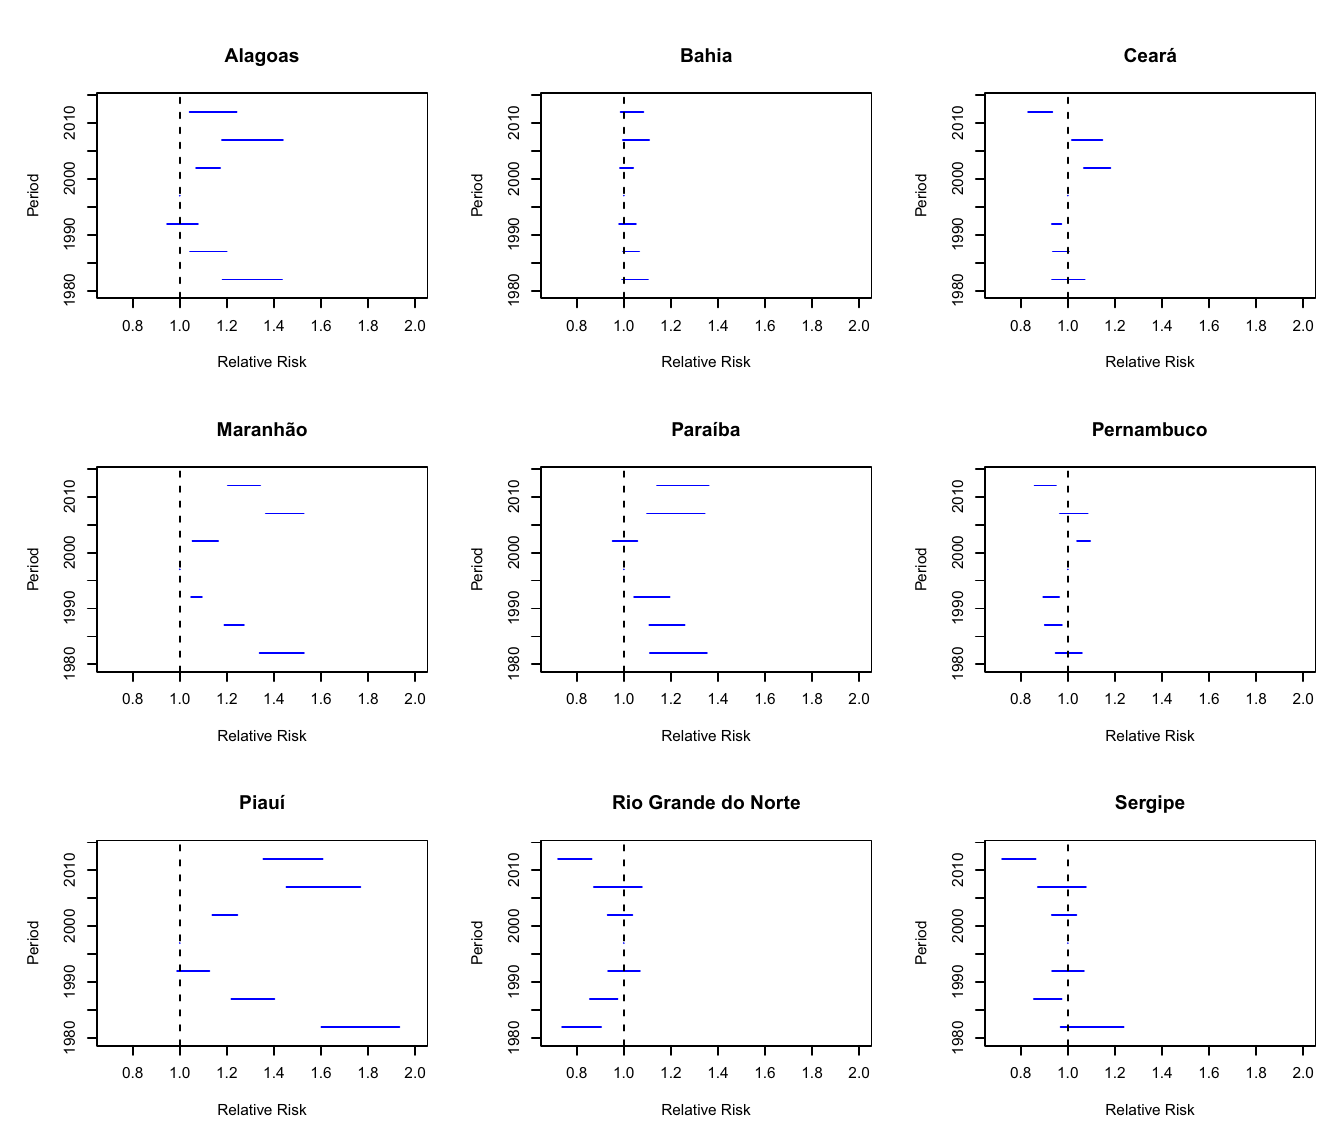
Fig 7. Results of the age-period-cohort model adjusted for cervical cancer mortality according to the period effect and states of the Northeast, Brazil, 1980–2014. correction processes in the inner cities. Prior to the correction process, higher mortality and upward trend in cities in the Northeast with the best socioeconomic conditions and lower mortality rates and downward trend in cities with the worst socioeconomic conditions. How- ever, an inverse profile was verified after the correction process. This reality is correlated with disparity in access to health care, and therefore women living in poorer locations in Brazil are less likely to diagnose their disease, contributing to poor quality of SIM/DATASUS data infor- mation [19,37–38]. cervical cancer in all five-year periods (1980–1984 to 2010–2014) compared to places with greater socioeconomic development and better access to health services [1,10,20].